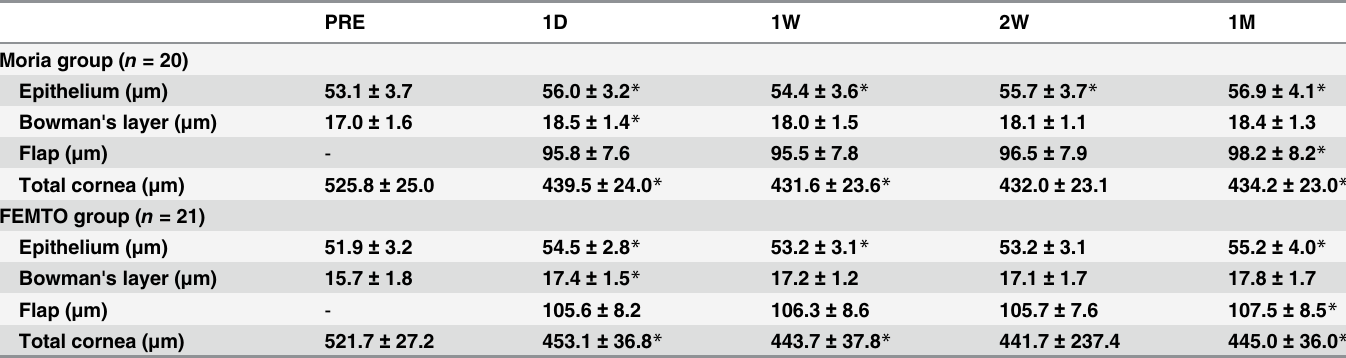
and 3, Fig 4). However, changes in Bowman 0 s layer thickness between 1 day and 1 month after SBK were not significant for either flap creation method. Table 2. UHR-OCT measurements of central corneal sublayer thicknesses before and after sub-Bowman 0 s keratomileusis (SBK). PRE 1D 1W 2W 1M Moria group ( n =